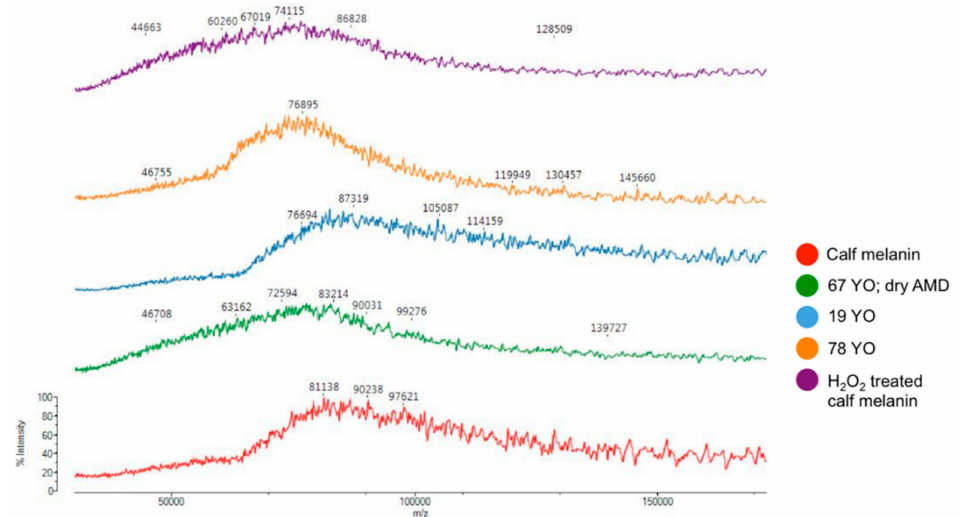
Figure 10. Comparative MALDI-MS profiles of melanin, reproduced with permission from Ref. [97]. (67 YO; dry AMD = 67-year-old donor; dry age-related macular degeneration sample; 19 YO = 19-year-old donor sample; 78-year-old donor